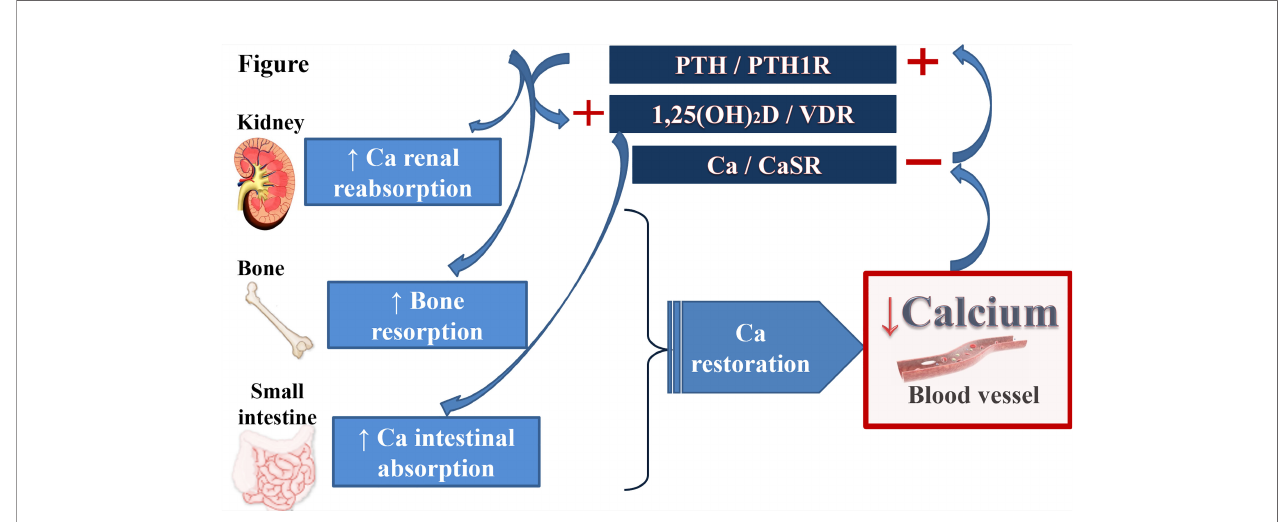
FIGURE 1 | Calcium homeostasis. Calcium homeostasis is fi nely regulated by a complex hormonal system including several hormones and its receptors (PTH/ PTHrP and its receptor PTH1R; 1,25(OH) 2 D) and the vitamin D receptor; ionized calcium itself and CaSR) and 3 main target-organs (kidney, gut and bone). A decrease in serum calcium inactivates the CaSR in the parathyroid glands and in the kidney. It causes an increase in PTH secretion which in turn, stimulates renal and bone reabsorption. PTH promotes the synthesis of 1,25(OH) 2 D in the kidney leading to the increase of intestinal calcium absorption and to a feedback loop inhibition of PTH secretion. Inactivation of CaSR in the kidney leads to additional calcium reabsorption and enhancement of the renal PTH action of PTH. In contrast, an increase in serum calcium level increases calcium excretion and bone storage. PTH, parathyroid hormone; PTHrP, PTH-related Protein; PTH1R, PTH-1 receptor; CaSR, calcium-sensing receptor; 1,25(OH) 2 D, 1,25-dihydroxyvitamin D; VDR, vitamin D